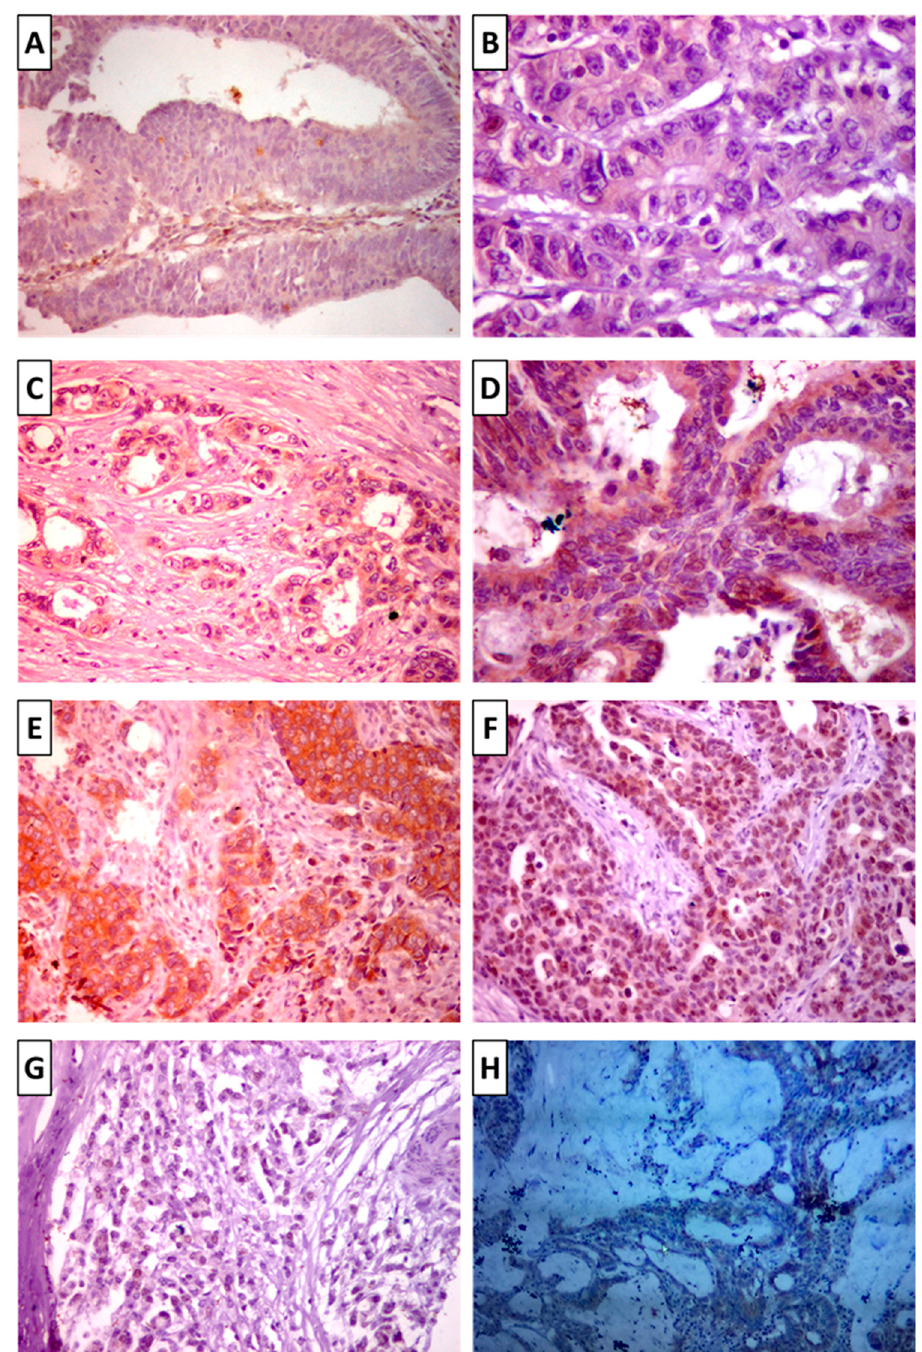
Figure 2. Immunohistochemistry staining for Braf mutant (BRAF V600E ) protein. ( A ) Well-differentiated adenocarcinoma showing negative staining of BRAF (×200). ( B ) Well-differentiated adenocarcinoma showing weak cytoplasmic staining (×400). ( C ) Moderately differentiated adenocarcinoma showing moderate cytoplasmic staining (×200). ( D ) Moderately differentiated adenocarcinoma showing strong cytoplasmic staining (×400). ( E ) Poorly differentiated adenocarcinoma showing cytoplasmic staining (×200). ( F ) Poorly differentiated adenocarcinoma showing nuclear staining (×200). ( G ) Signet ring nuclei showing scattered few positively stained nuclei (200). ( H ) Mucinous adenocarcinoma showing negative staining of the BRAF mutation (×100).